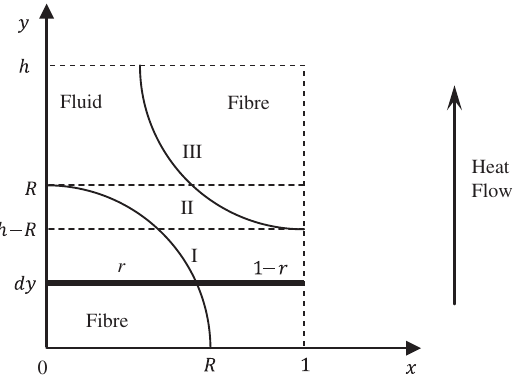
Figure 4 Heat flow in a quarter cross-section of hexagonal fibre array.